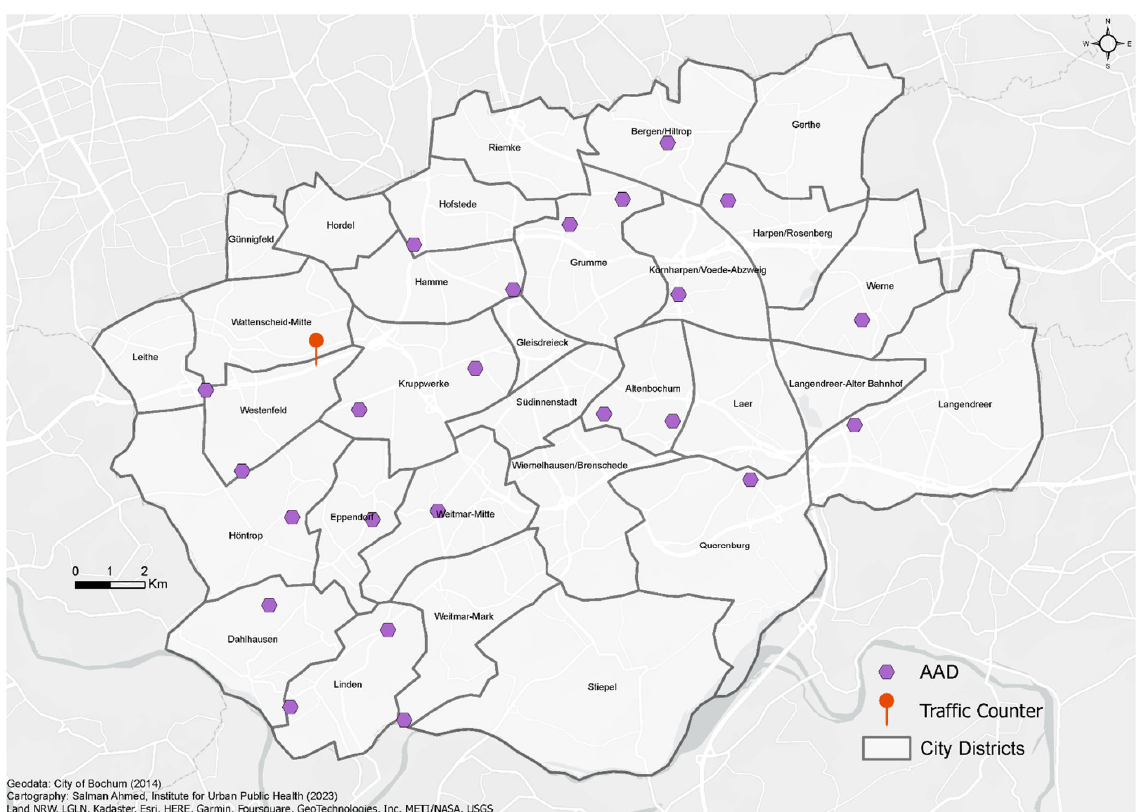
Figure A2. City districts with the depicted locations of AADs and traffic counting station No. 5113 in the city of Bochum, Germany.